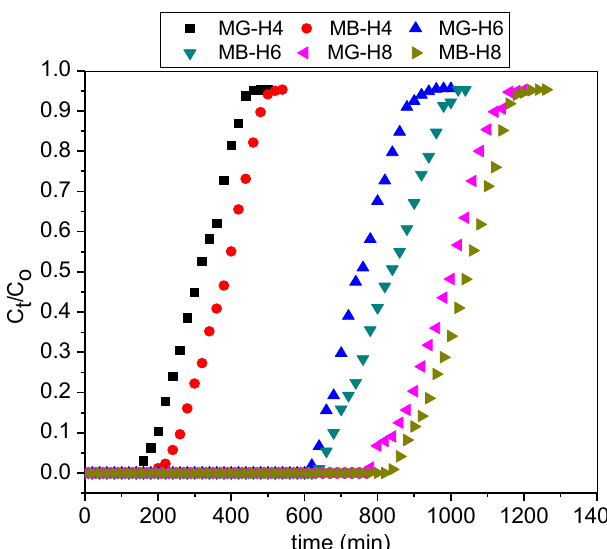
Figure 8. Breakthrough curves for adsorption of MG and MB in the binary system at varied bed height (pH: 9; C 0 : 50 mg / L; Q : 3.0 mL / min).